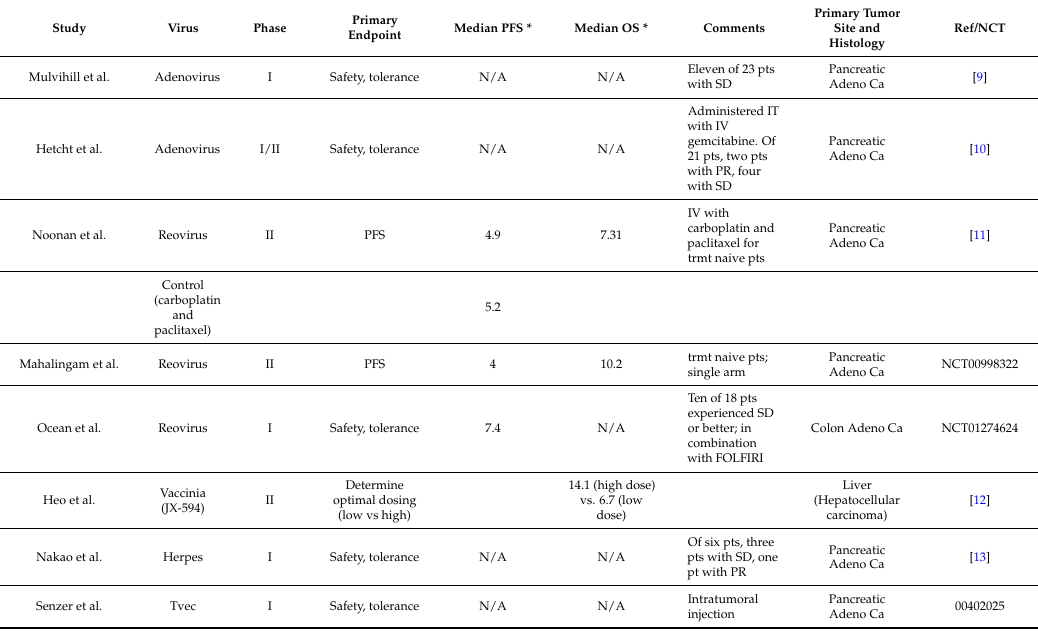
Table 1. Summary of key completed phase I/II clinical trials investigating oncolytic viruses in gastrointestinal